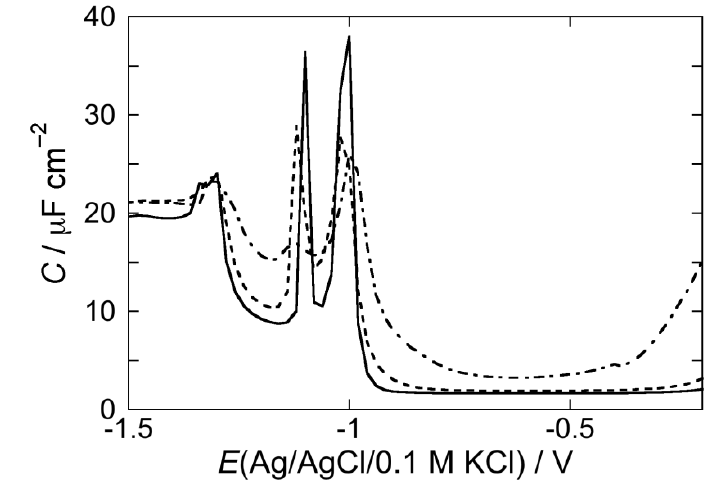
Figure 3. AC voltammogram at a DOPC SAM in a pH 3 solution of 0.1 M KCl in the absence of the type I’ β -turn peptide structure CSF114 (solid curve), and in the presence of 2 μg/mL CSF114 after five potential scans from –0.2 to –1.5 V (dashed curve) and after a single EIS scan (dash-dotted curve). Frequency = 75